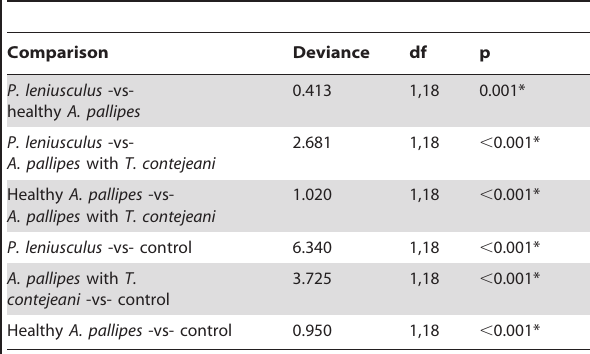
Table 1. Pairwise linear model comparisons between crayfish groups in mobile prey consumption. Table 2. Pairwise linear model comparisons between crayfish groups in non-mobile prey